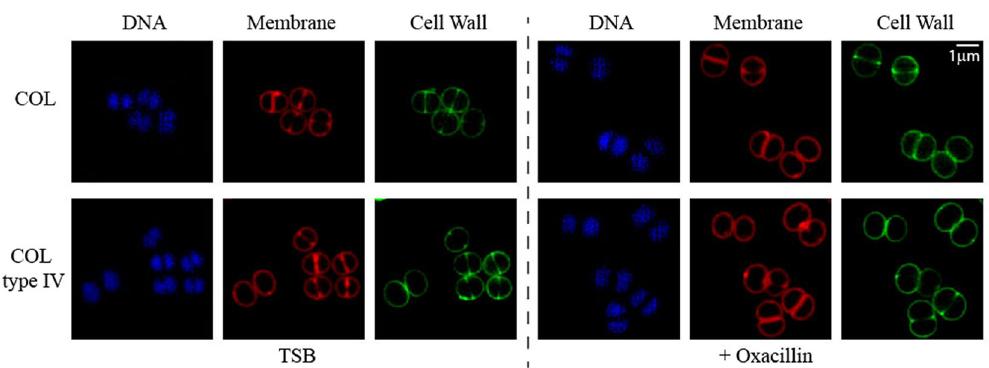
Figure 4. Structured Illumination Microscopy (SIM) of COL and COL type IV in response to oxacillin challenge. COL and COL type IV were grown to early exponential phase before incubation for 1 h with oxacillin (256 µ g/ml and 512 µ g/ml, respectively). Cell were next incubated with Hoechst3332 (blue), Nile Red (red) and a fluorescent derivative of vancomycin (green) in order to stain the DNA, cell membrane and cell wall, respectively. Visualisation by SIM shows that the cell morphology of COL type IV is similar to COL, both in the presence and absence of